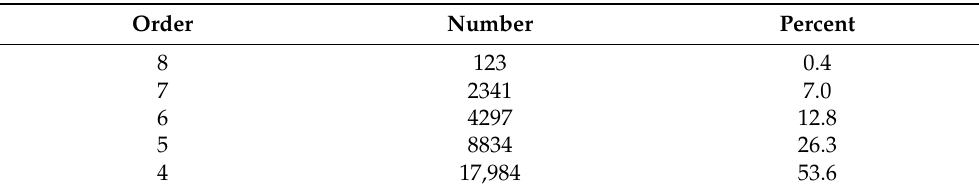
Figure 1. Study region, defined by USGS Region-3 boundary (grey outlines delineate individual watersheds). Blue lines denote NWM stream segments with Strahler stream order ≥ 4 ( n = 33,759), while grey and green dots denote USGS daily streamflow observation gauges with a period of record of 1994 – 2018 ( n = 520). Green dots specifically denote USGS gauges with <5% missing data and a corresponding NWM stream segment ( n = 342). Table 1. Distribution of NWM stream segments over the study region by Strahler stream order. Only segments with order ≥ 4 are considered in the percent calculation.